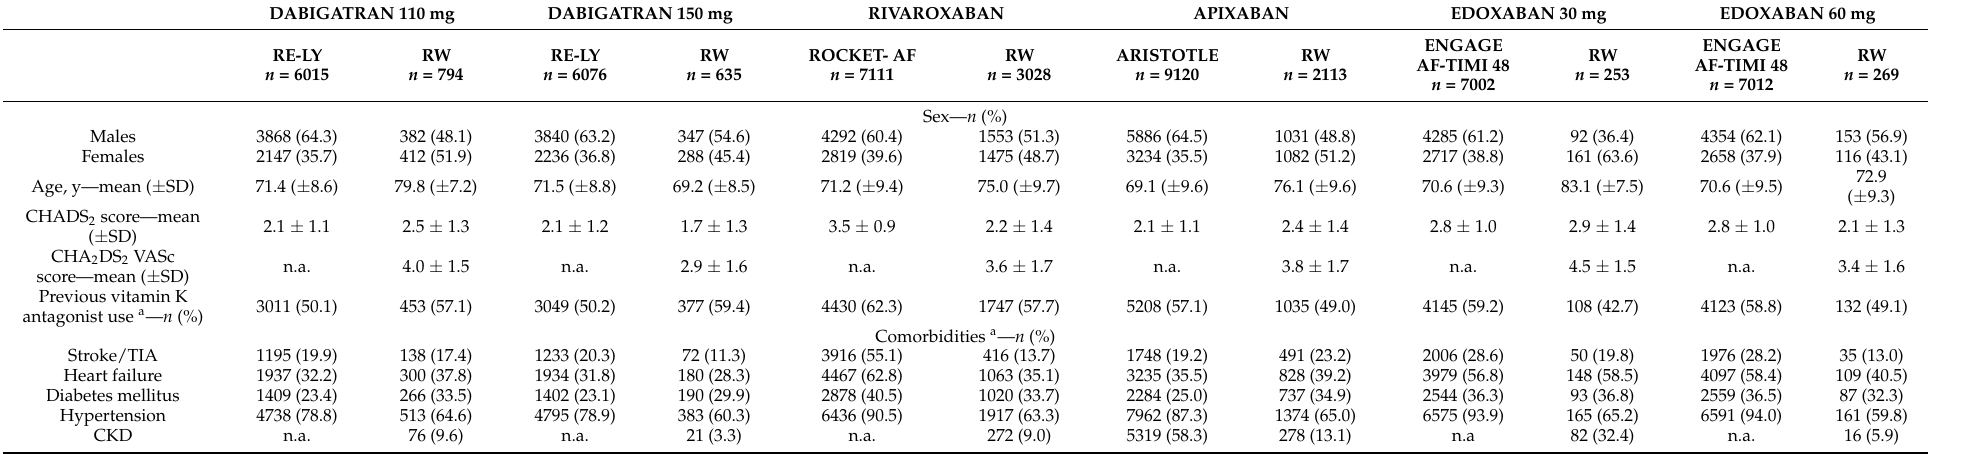
Table 1. Comparison of baseline characteristics of real-world (RW) population vs. randomized controlled trial (RCT) population, stratified by individual drug and dosage.